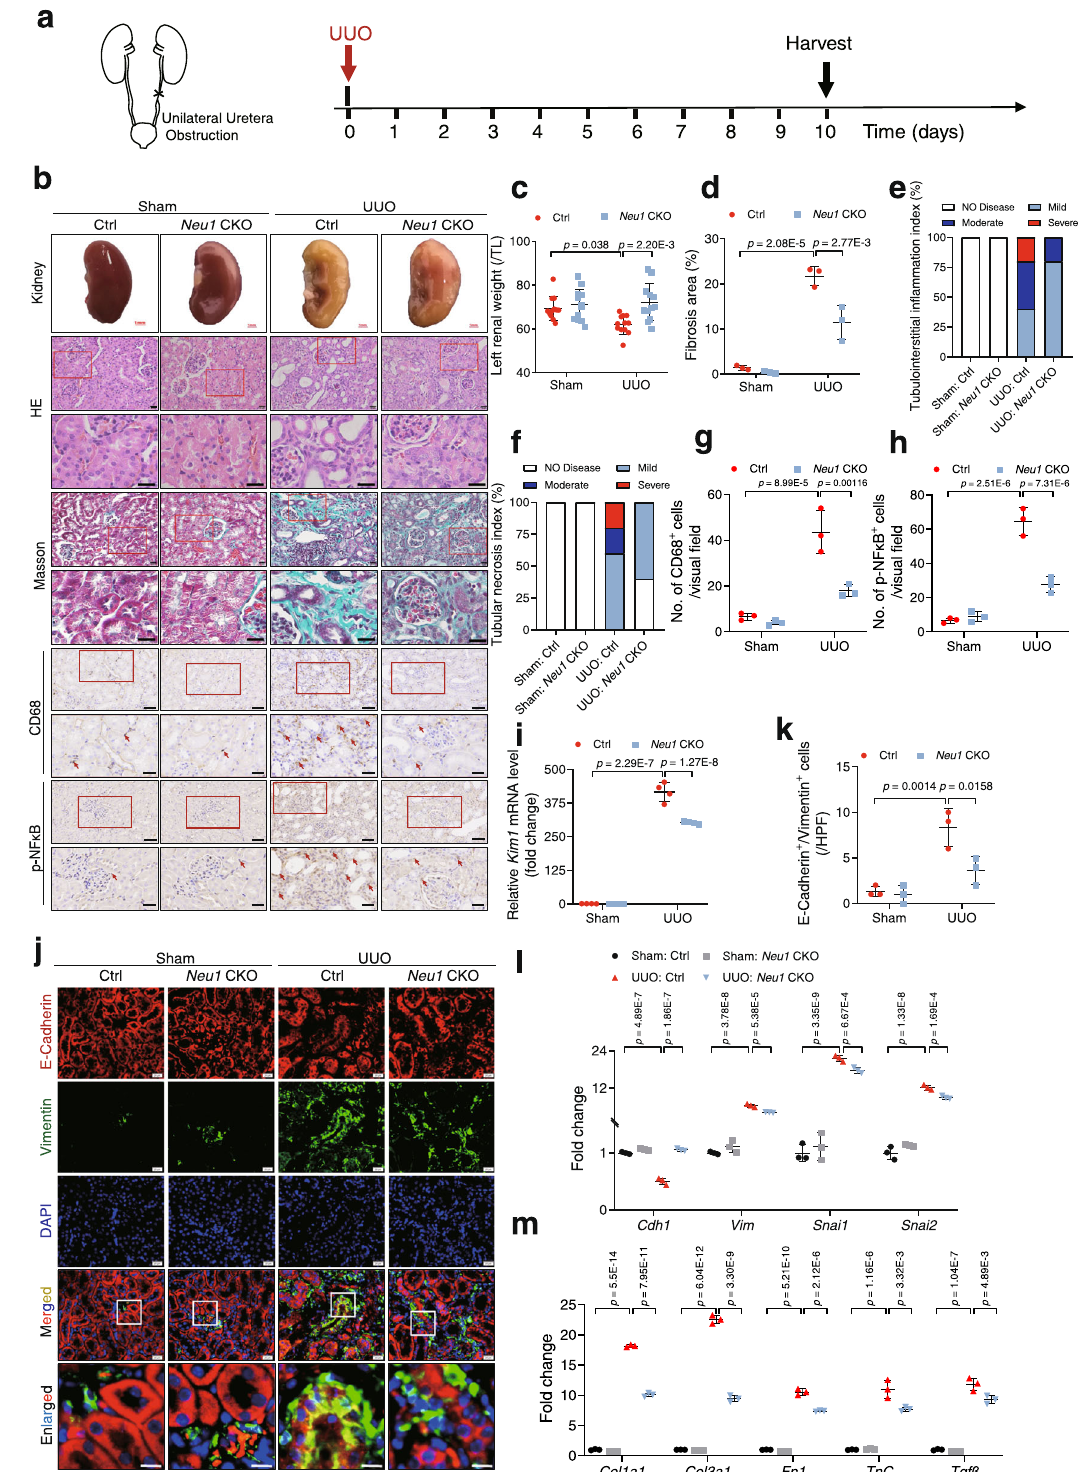
Fig. 3 | TEC-speci fi c deletion of Neu1 alleviates UUO-induced mouse renal fi brosis. a Scheme of the experimental approach. UUO, unilateral ureteral obstruction. b Thegrossappearanceofkidneys(Scalebar,1mm),Hematoxylinand eosin (HE, Scale bar, 20 μ m), Masson ’ s trichrome staining (Scale bar, 20 μ m), immunohistochemistry staining of CD68, and p-NF κ B (Scale bar, 50 μ m) from control (Ctrl) and Neu1 CKO mice 10 days after UUO. The red arrow indicates positive cells. n =3 mice per group. c The ratio of left renal weight to tibia length (TL). n =12micepergroup.( d )Statisticalresultsforinterstitialcollagenanalyzedby Image Pro-Plus software. n =3 mice per group. e , f Morphometric analysis,